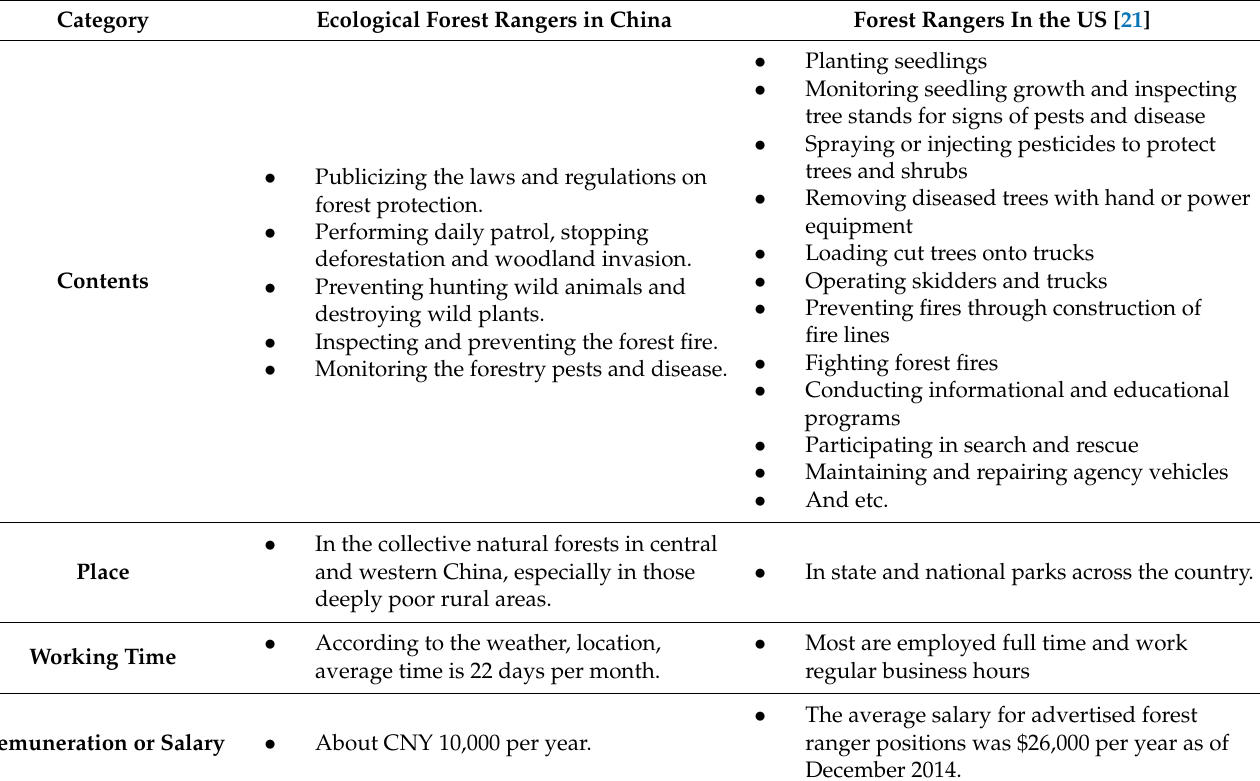
Table A1. Difference between China and the